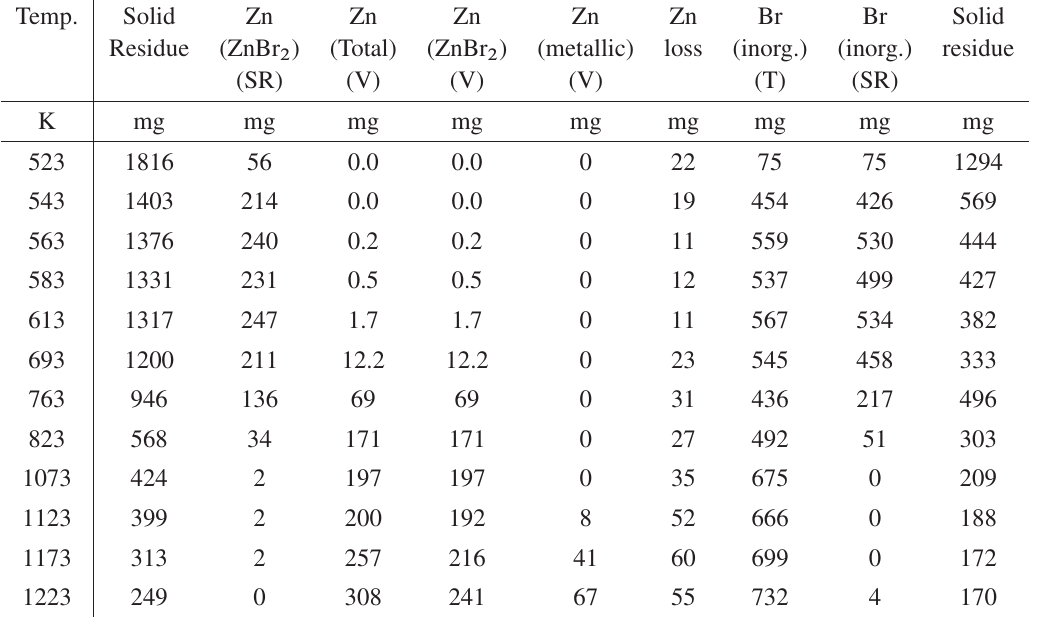
Table 1. Main data obtained from experiments on isothermal treatment of TBBPA:ZnO (3.34:1) in Argon atmosphere for 40 min. The initial weight of sample was 2000 mg, with an initial zinc content of 363